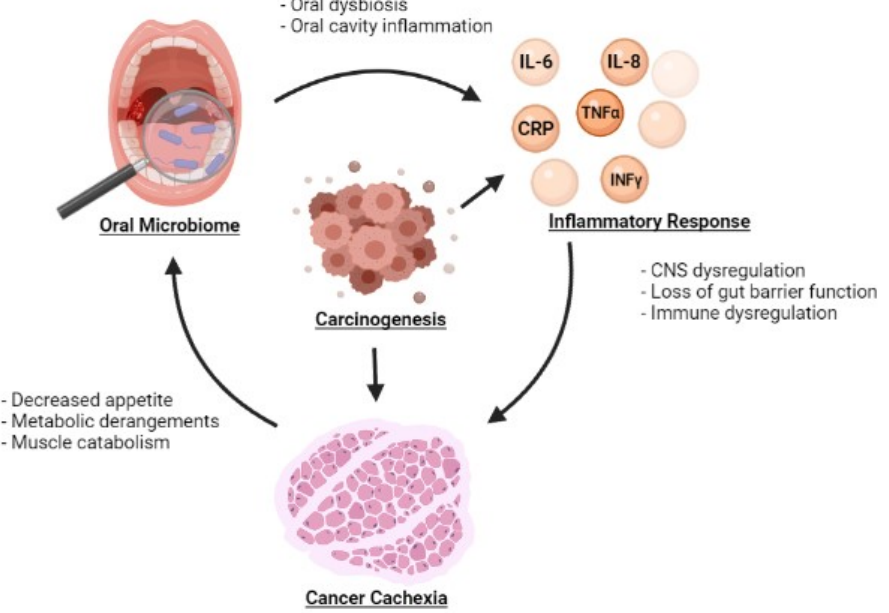
Figure 1. Relationship between the oral microbiome, inflammatory markers, and development of cancer cachexia.